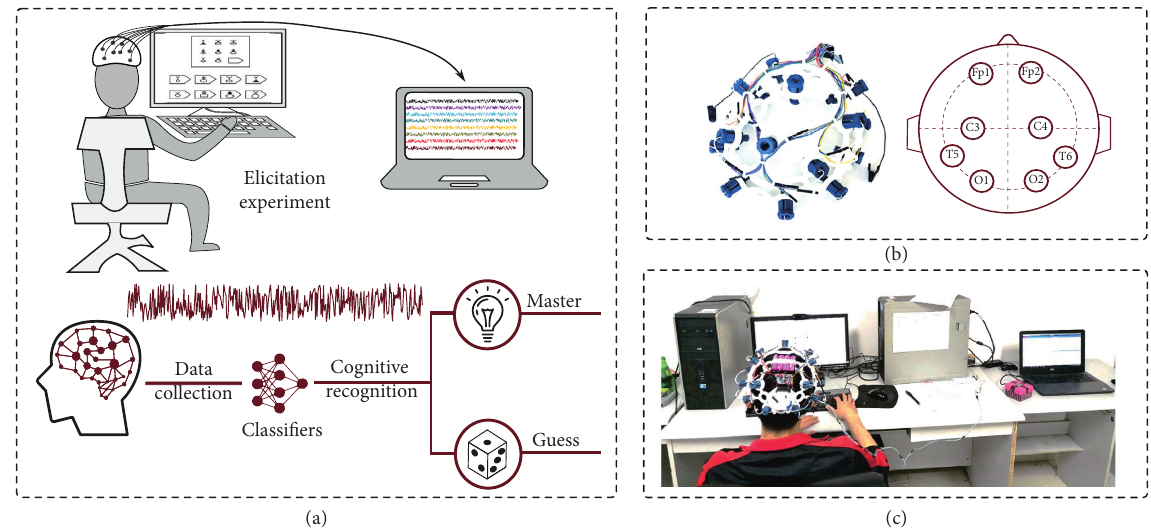
Figure 5: (a) The flow of EEG data collection and the recognition of “guessing” and “understanding”. (b) The open BCI acquisition device and 8 channel positions. (c) One of the subjects was watching the stimulus and selecting items in the experiment. At the same time, EEG data were collected and visualized on the screen of another